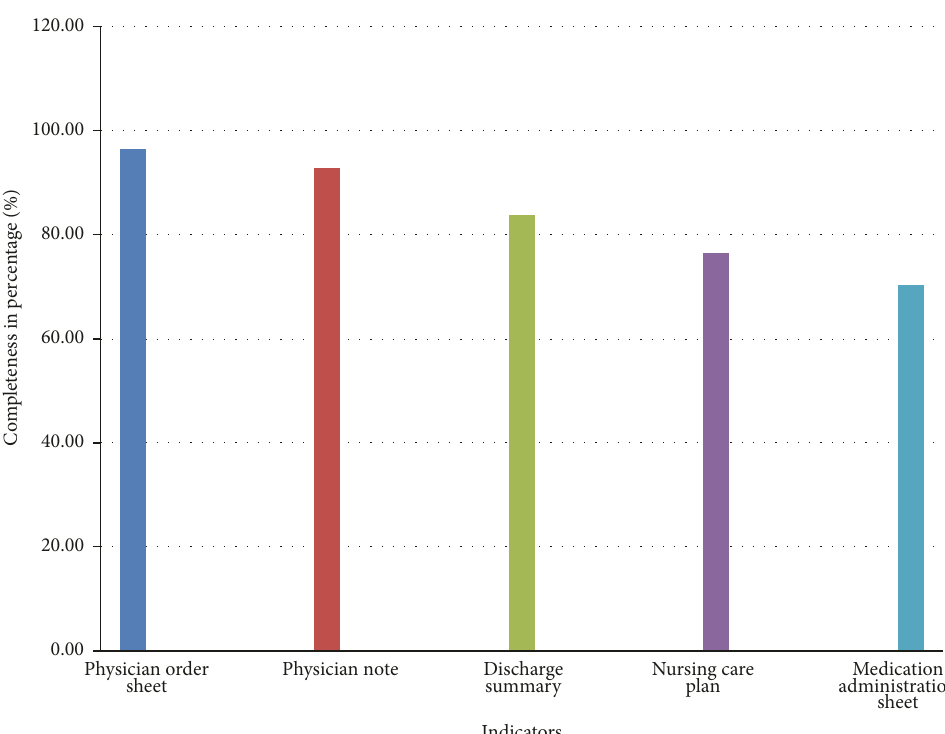
Figure 1: Status of completeness of medical record completeness in Menelik II Referral Hospital, Addis Ababa, Ethiopia, May 2016.